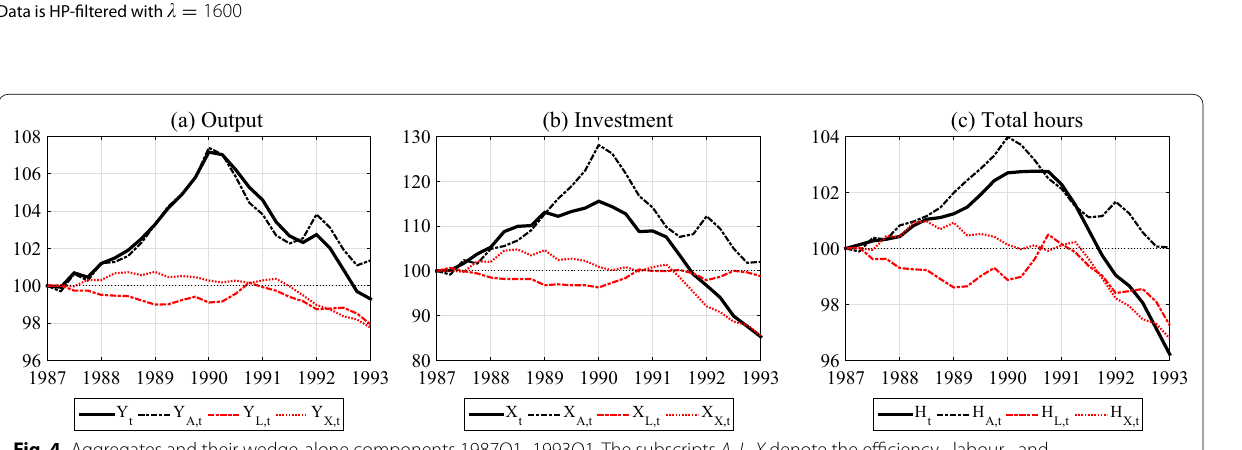
Data is HP-filtered with (cid:31) = 1600